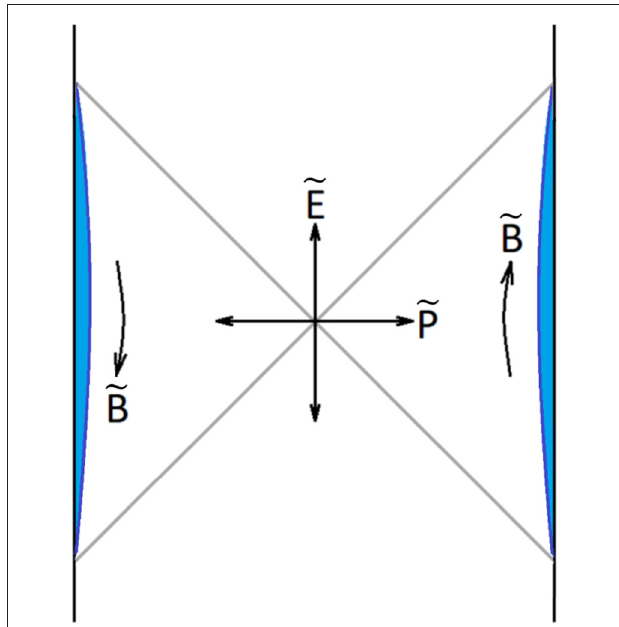
FIGURE 9 | Embedding a finite throated geometry in AdS 2 . Also shown are the three SL (2, R ) gauge generators. The blue regions are part of the embedding space but not part of the actual finite temperature spacetime. The inner boundaries of the blue region are the dynamical boundaries governed by the Schwarzian action.